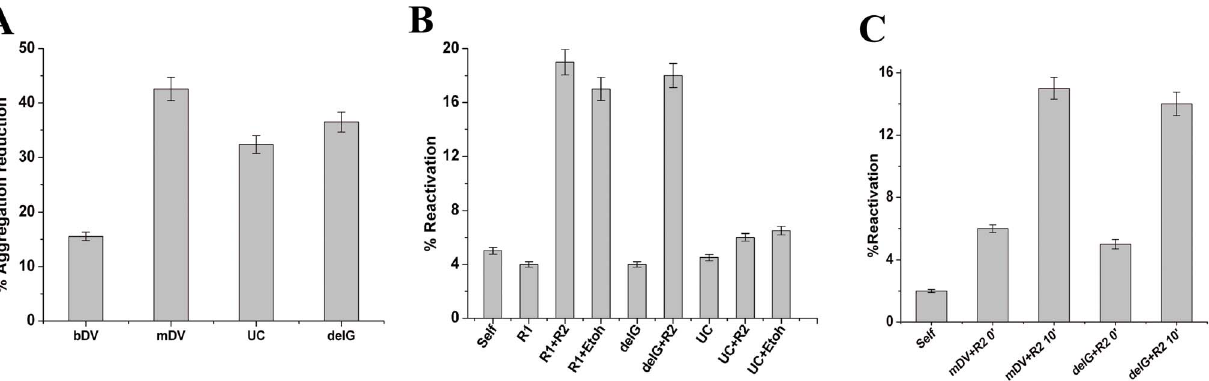
Figure 4. Effects of bDV RNA mutants on refolding of BCAII. A) Bar diagram shows percent aggregation reduction during BCA II-m refolding by bDV RNA, mDV RNA and bDV RNA mutants U2585C (UC), delG2252 (delG). The turbidities in each case were measured at 320 nm, 12 minutes after return to refolding conditions and turbidity in absence of chaperone was assumed as 100%. B) Comparison of reactivation yields of BCAII-m (0.3 m M) after 30 min of refolding in absence of the chaperone (Self) and in presence of bDV RNA1(R1), bDV RNA1 + RNA2 (R1 + R2), RNA1 + 3% Ethanol (R1 + EtOH), del G2252 bDV RNA (delG), del G2252 + RNA2 (delG + R2), U2585C (UC), U2585C bDV RNA + RNA2 (UC + R2) and U2585C bDV RNA + 3% Ethanol (UC + EtOH). C) Comparison of the reactivation yields of BCAII-m (0.9 m M) after 30 min of refolding in absence of the chaperone (Self), in presence of del G2252 bDV RNA and mDV RNA. BCAII-m reactivation upon addition of RNA 2 portion of bDV at zero minute (mDV + R2 0 9 and delG + R2 0 9 ) and after ten minutes of initiation of refolding (mDV + R2 10 9 and delG + R2 10 9 ) are also shown.